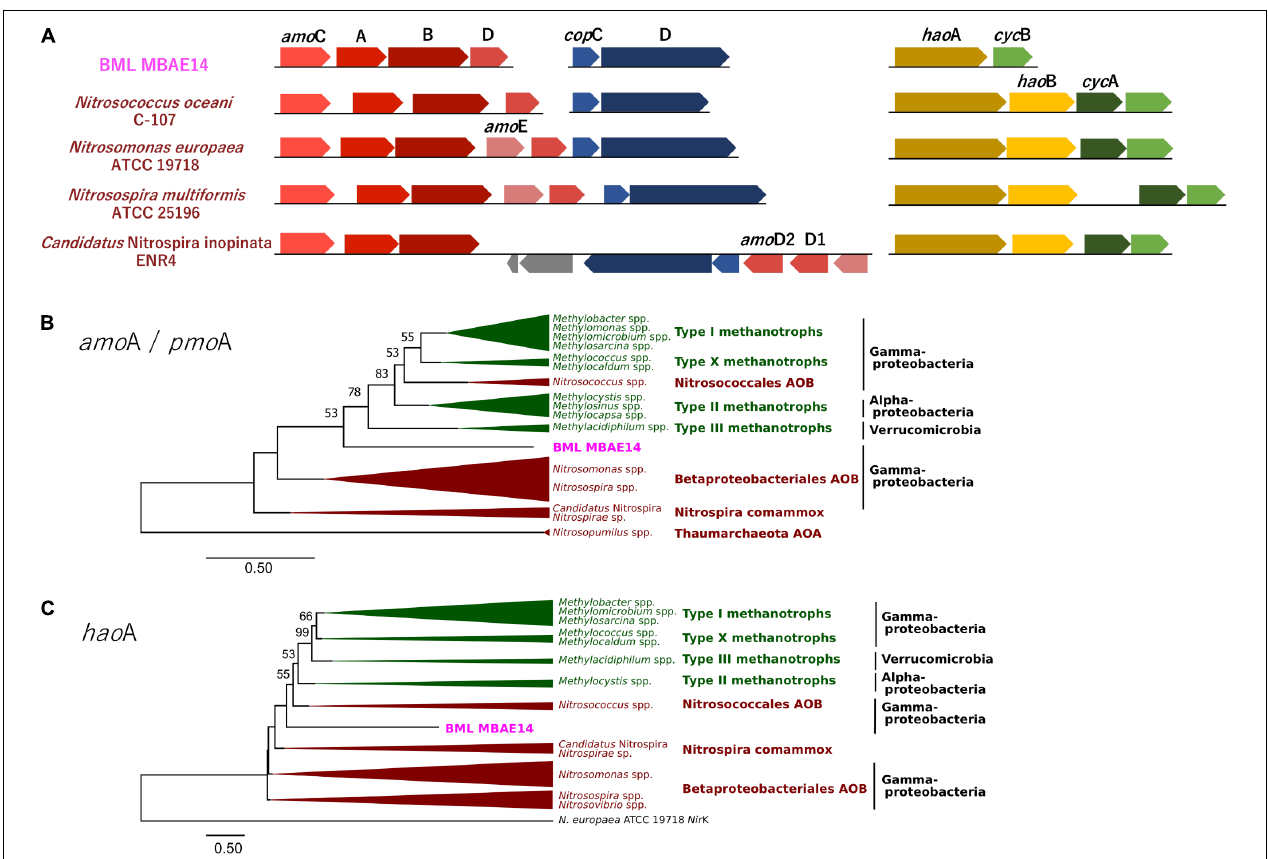
FIGURE 5 | (A) Gene clusters of amo and hao genes encoded by BML MBAE14 and other known AOB. (B,C) Maximum-likelihood phylogenetic trees of the functional genes amo A/ pmo A (B) and hao A (C) found in BML MBAE14 (pink) and typical groups of ammonia oxidizers (brown) and methanotrophs (green). The tree was rooted with the genes of Nitrosopumilus spp. (Thaumarchaeota AOA) amo A gene (B) and Nitrosomonas europaea ATCC19718 Nir K gene (C) and created with 1000 bootstrap iteration (values below 50% are not reported).